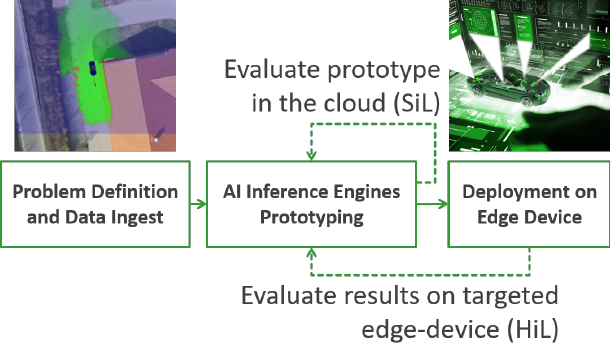
Figure 1. AI Inference Engine concept. Deep learning based inference engine evaluated at the prototyping level within the Cloud as Software-in-the-Loop (SiL), as well as on the targeted edge device Electronic Control Unit (ECU), as Hardware-in-the-Loop